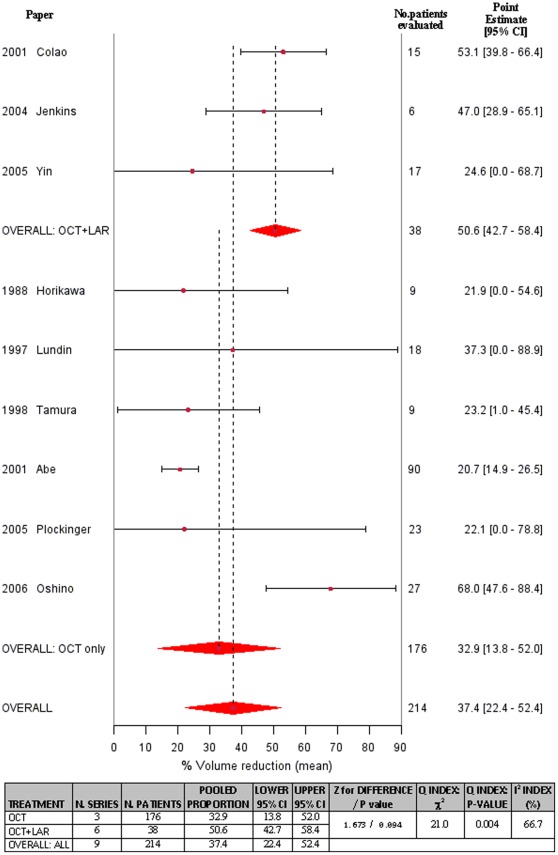
Forest plot depicting percentage change in tumor volume CI, confidence interval.